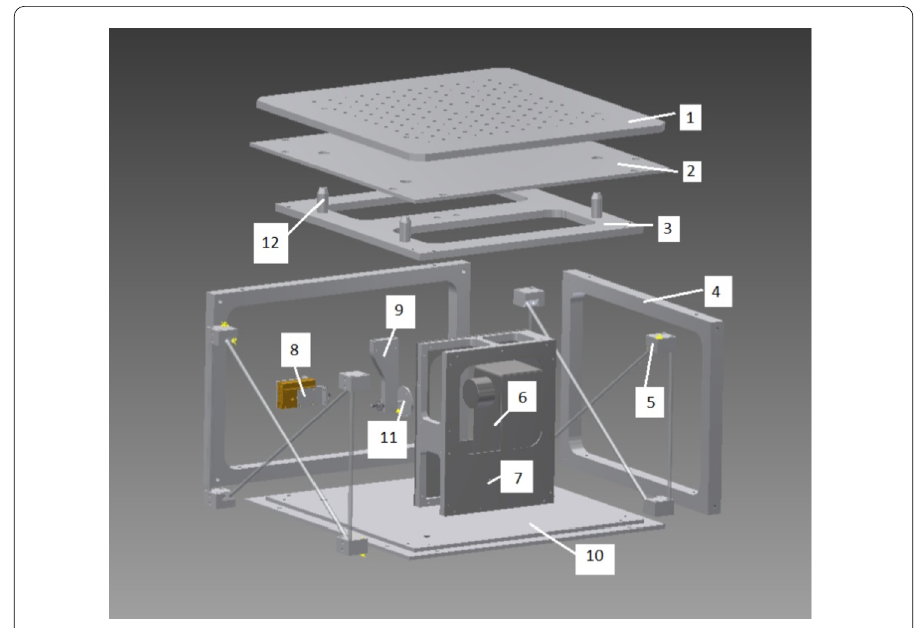
Figure 6 Assembly sketch of the main components of the DEPB device. The eddy current brake not shown here. Parts: 1 thruster platform; 2 housing top plate; 3 upper moving platform; 4 housing frame; 5 flexible bearing rod assembly; 6 weigh cell; 7 weigh cell supporting frame; 8 calibration stage assembly; 9 Force transmission piece with screw; 10 base plate; 11 contact piece; 12 connection stud to thruster platform